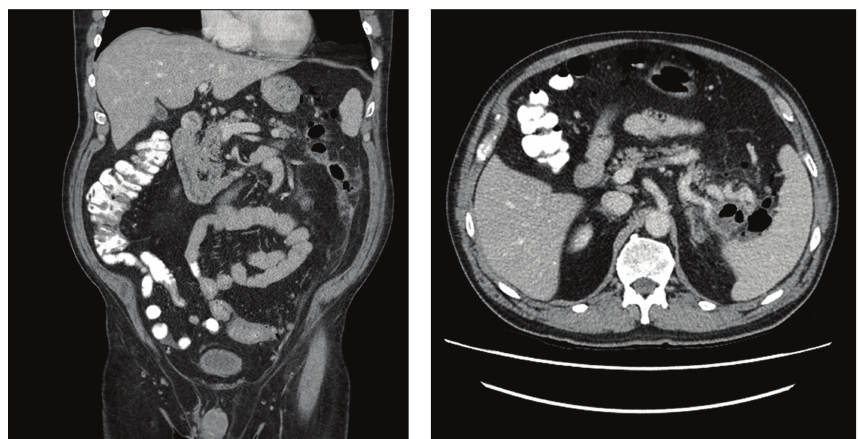
Figure 1: Perforation showing free air in the peritoneum in the area of splenic flexure.